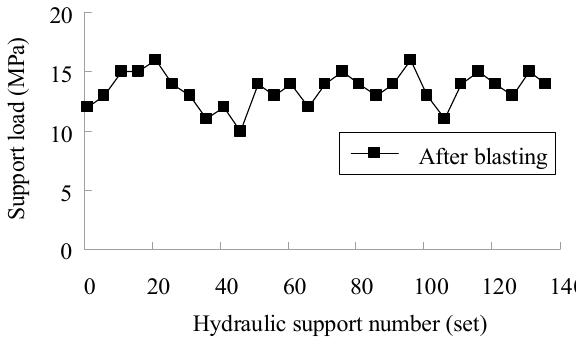
Figure 12. Support pressure figures after deep-hole blasting.